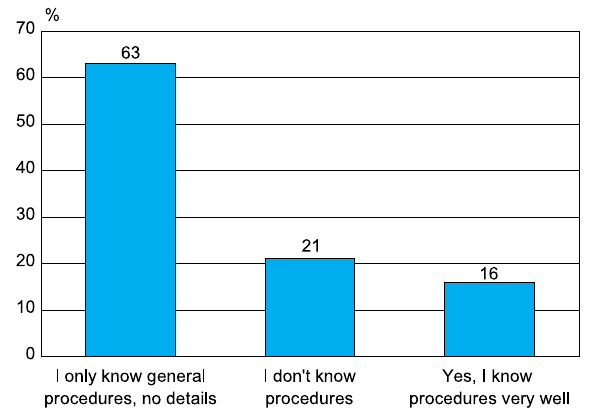
Fig. 6. Knowledge of public consultation participants about planning